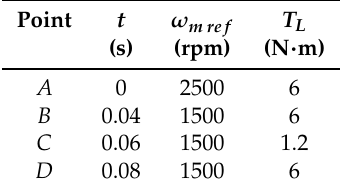
Table 4. Operational range for